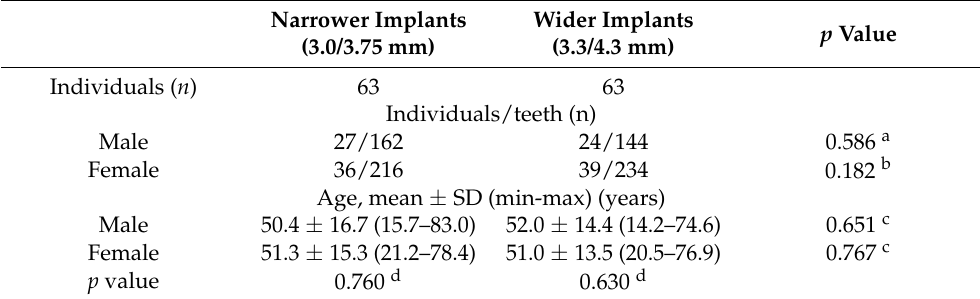
Table 1. Description of the cohort group, according to the groups of implant diameter and sex.